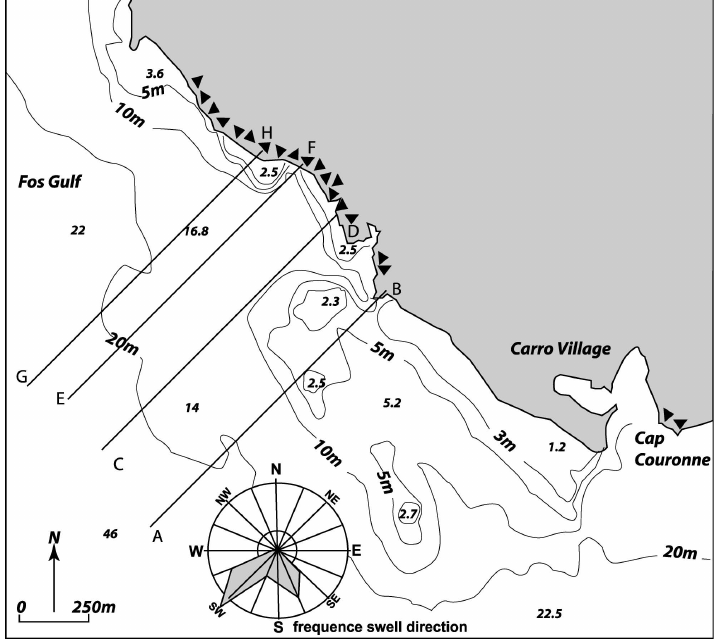
Fig. 2. Bathymetric map with positions of boulders (dark triangles) and location of profiles. Frequency of swell from Cap Couronne between